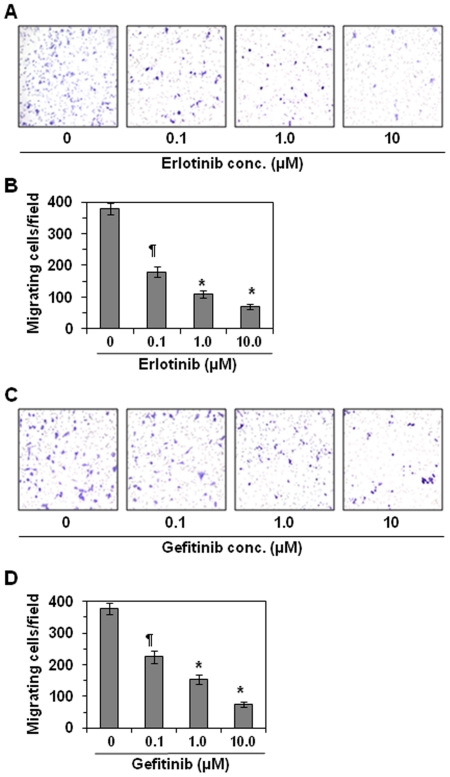
Effect of the EGFR inhibitors, gefitinib and erlotinib, on HNSCC cell invasion.(A) OSC19 cells were treated with the indicated concentrations of erlotinib, a small molecule inhibitor of EGFR, for 48 h and the effects on invasion assessed as described in Figure 1. Crystal violet staining of the membrane shows that erlotinib inhibited invasion of OSC19 cells in a concentration-dependent manner. (B) The invasive cells were counted and the results expressed as the mean number of invasive cells±SD/microscopic field, magnification: ×10. (C) Similarly, treatment of OSC19 cells with the indicated concentrations of gefitinib, a small molecule inhibitor of tyrosine kinase activity and, thus, of EGFR, inhibited cell invasion in a dose-dependent manner as indicated by crystal violet staining of the membrane. (D) The invasive cells from the experiment described in Figure 3C were counted and the results expressed as the mean number of invasive cells±SD/microscopic field, magnification: ×10. Significant reduction of cell invasion versus untreated control cells, ¶
P<0.05, *
P<0.001.